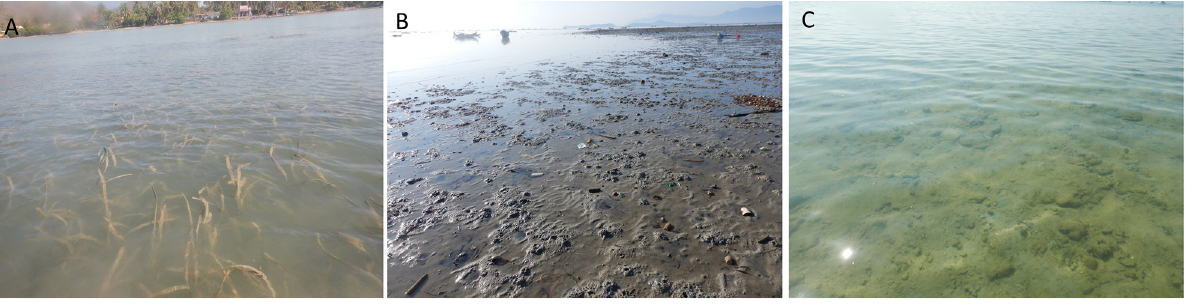
Fig. 3. Different shallow substrata at XT, A = seagrass beds, B = muddy sand with rock and C = the reef/sand substratum. See Figure 1 for the abbreviation of locations. Table 1. Sensor type, acquisition date and time of satellite image data sets used in the present